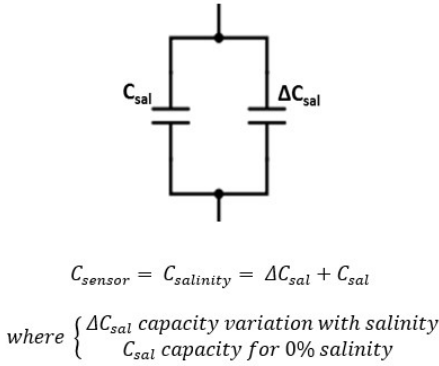
Figure 23. Sensor final electric model as a function of salinity.